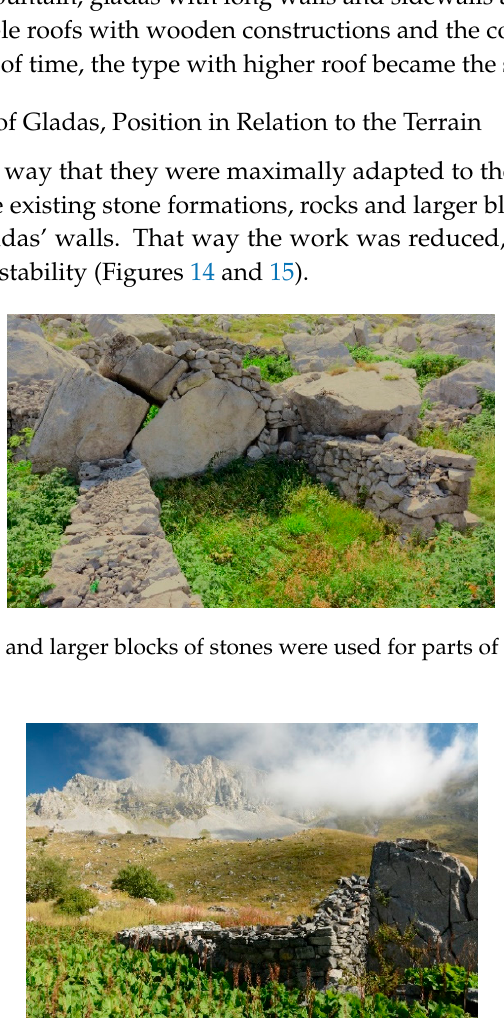
Figure 15. Existing boulder as the part of sidewall – Carine, katun of Popovi ć i, photo: I. Lakovi ć .